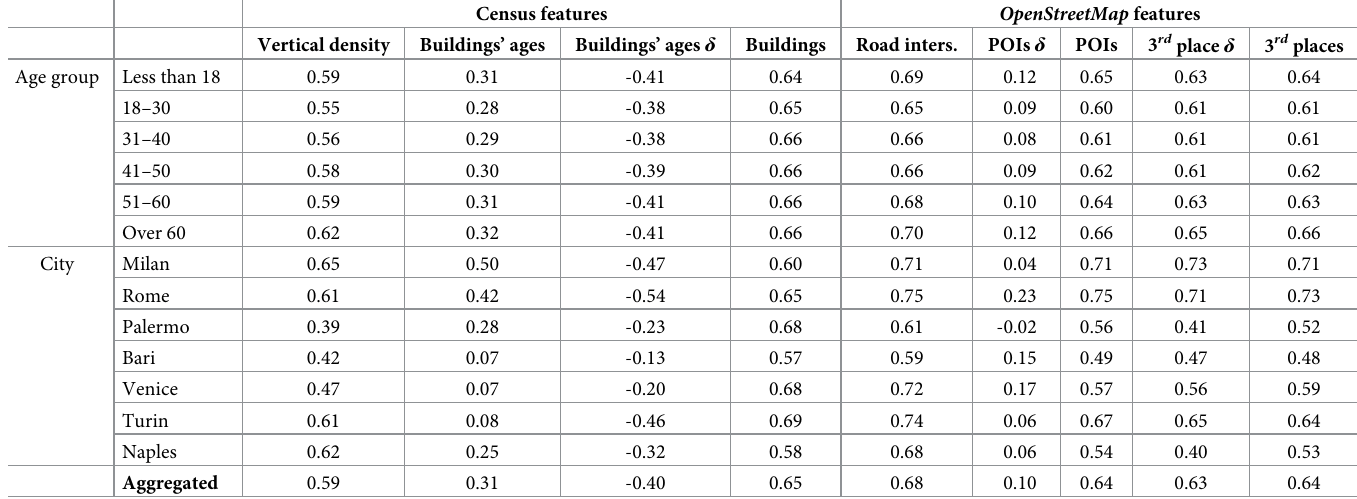
Table 2. Investigating the relationship between urban features and vibrancy. We perform an initial correlation analysis, using Kendall’s rank correlation coefficient, between the presence of people and urban features. Here, we present the results when aggregating different cities together, as well as when aggregating different age groups together. All p-values from the correlation tests have been adjusted using false discovery rate , and all values are significant ( p >